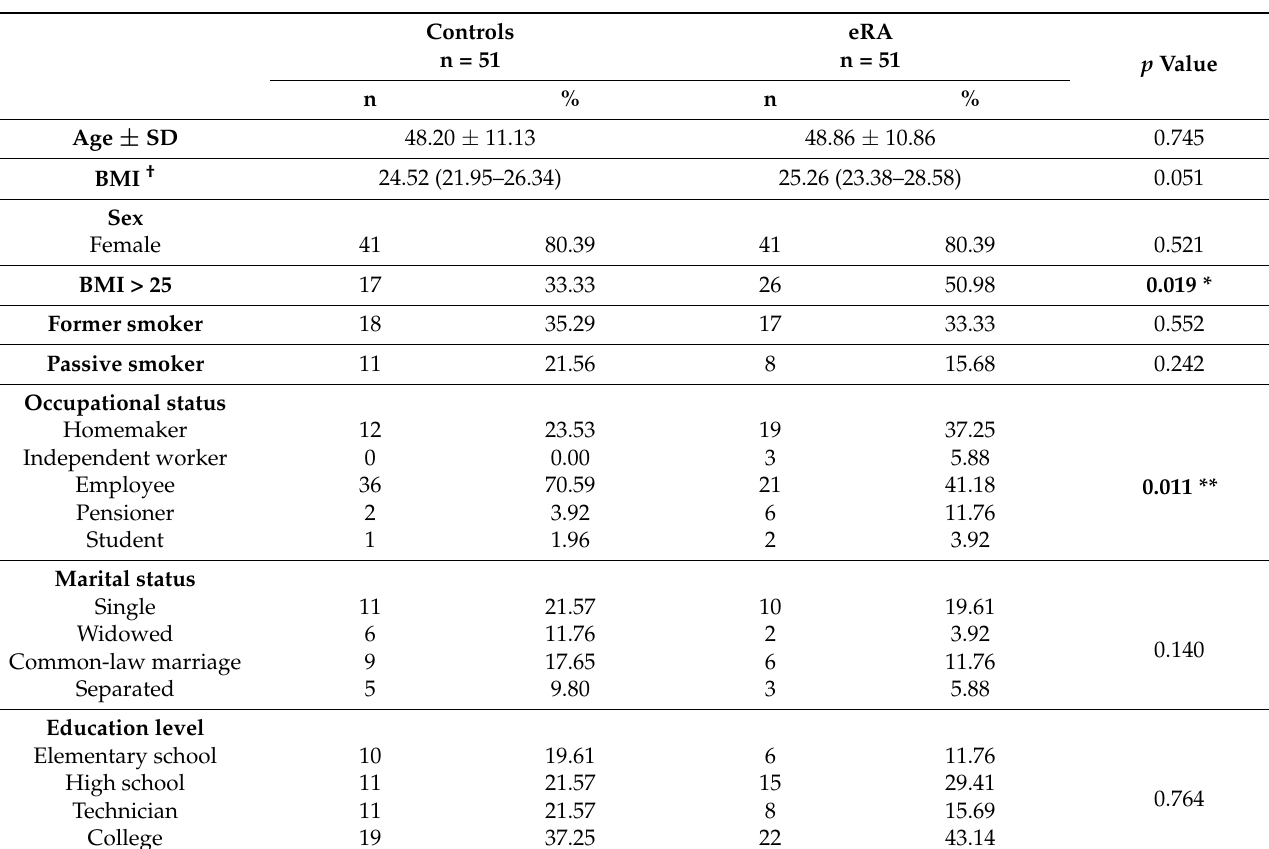
Table 1. Sociodemographic characteristics of patients with eRA and